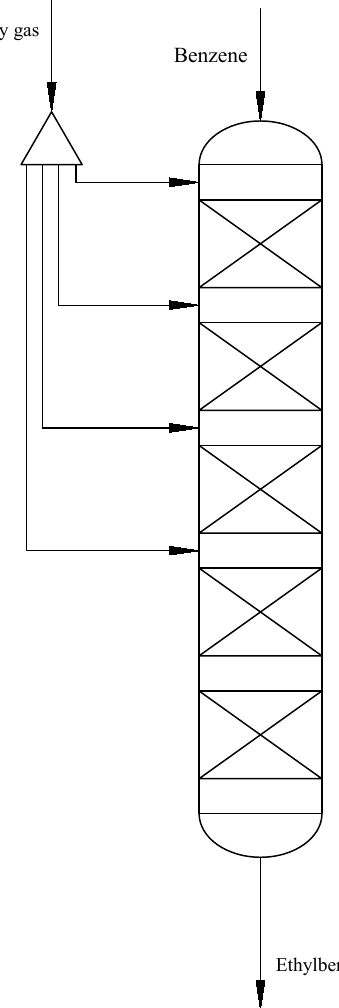
Figure 1. The alkylation reactor of EB